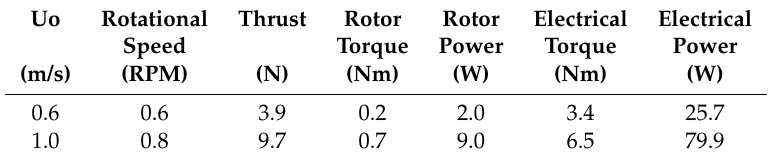
Table 11. Standard deviation of the mechanical and electrical variables using the BEMT/CFD approach. Uo Rotational Thrust